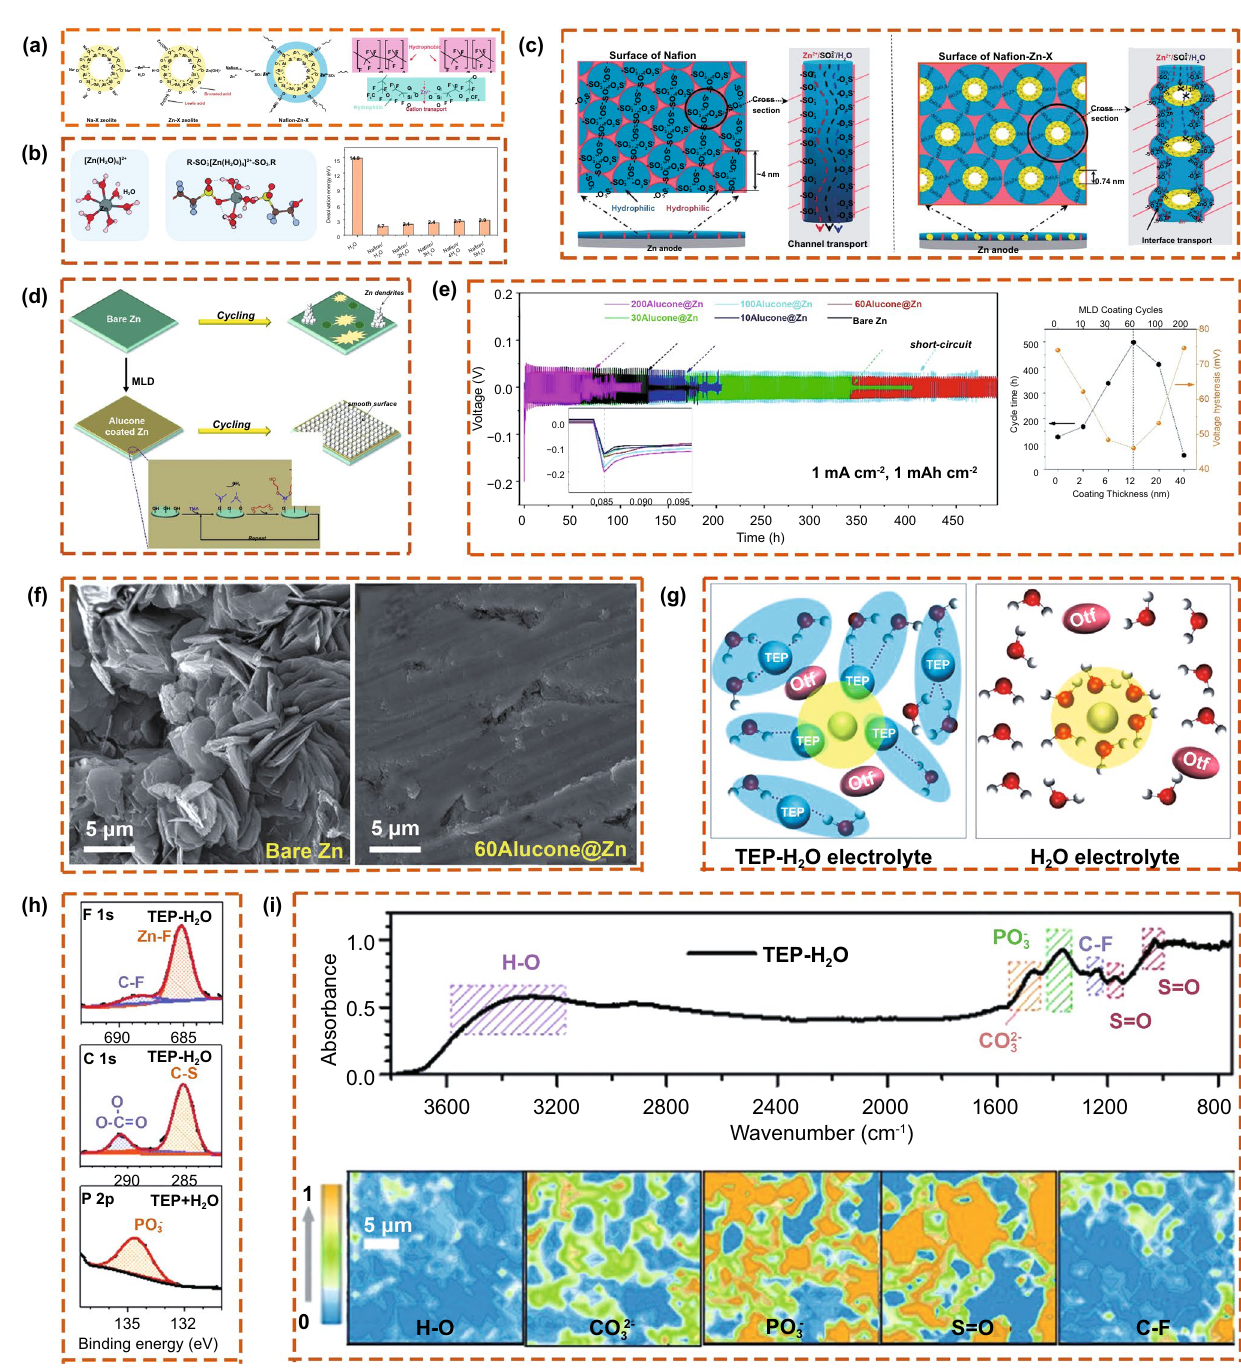
Fig. 13 a Schematic diagram of the formation process for the ~ SO 3− –Zn 2+ ~ bridge bond at the interface between organic Nafion and inorganic Zn-X zeolite and the organic structure of Nafion with Zn 2+ . b Coordination environment of Zn 2+ in water and Nafion with 4H 2 O and desolvation energy values of Zn 2+ in water or in Nafion with various H 2 O. c Ion transport mechanisms in Nafion and Nafion-Zn-X protective layers. Copy- right 2020 Wiley-VCH [26]. d Schematic illustration showing the effect of an inorganic–organic molecular layer deposition (MLD) alucone coat- ing on Zn metal anodes when cycling. e Galvanostatic charge–discharge profiles of symmetrical Zn cells with different electrodes at 1 mA cm −2 and an areal capacity of 1 mAh cm −2 , and statistical graphs of cycling time and voltage hysteresis against the coating thickness/MLD cycles. f Top-view morphologies of cycled bare Zn and 60Alcuone@Zn. Copyright 2020 Royal Society of Chemistry [106]. g Electrolyte solvation struc- ture and its influence on the V 2 O 5 dissolution of Zn(OTf) 2 -TEP-H 2 O electrolyte and pure aqueous electrolyte. Characterization of the interphase on the cycled Zn surface: h XPS fitted curves of the F 1s, C 1s, and P 2p elements and i the interference reflection microscopy spectrum of the cycled Zn electrode and the acquired distribution of surface functional groups. Copyright 2021 Wiley-VCH